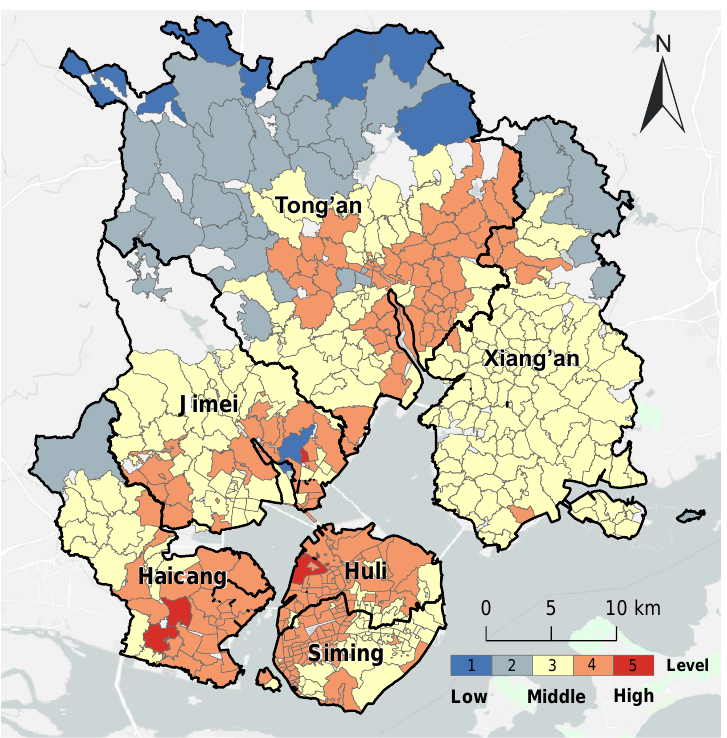
Figure 5. The spatial distribution of accessibility of internal medicine services in Xiamen City.